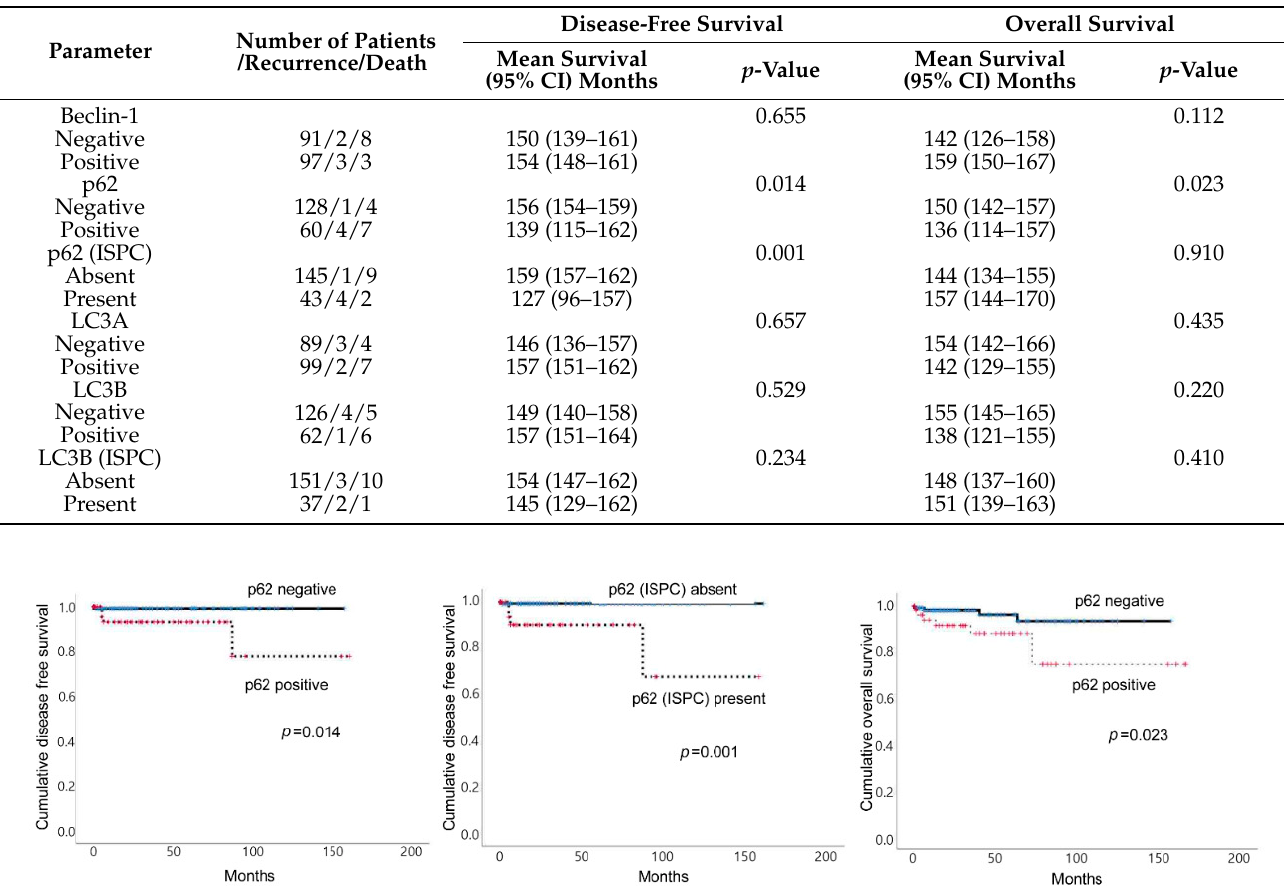
Figure 3. The presence/absence of clinicopathologic factors and the expression of autophagy-related proteins in adrenal cortical tumor and pheochromocytoma. Table 4. Univariate analysis of the impact of expression of autophagy-related proteins in pheochromocytoma on disease-free survival and overall survival by the log-rank test.